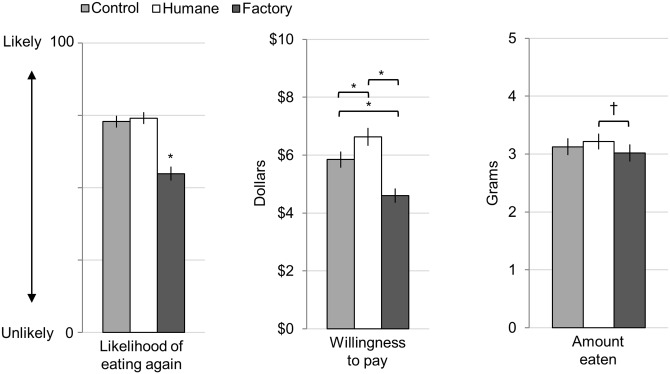
Study 3: Behavioral Measures for Ham Sample.Error bars represent standard errors. Asterisks represent significance (* p < 0.05), and dagger represents trend († p < 0.07). All ratings were made on 100-point slider scales.